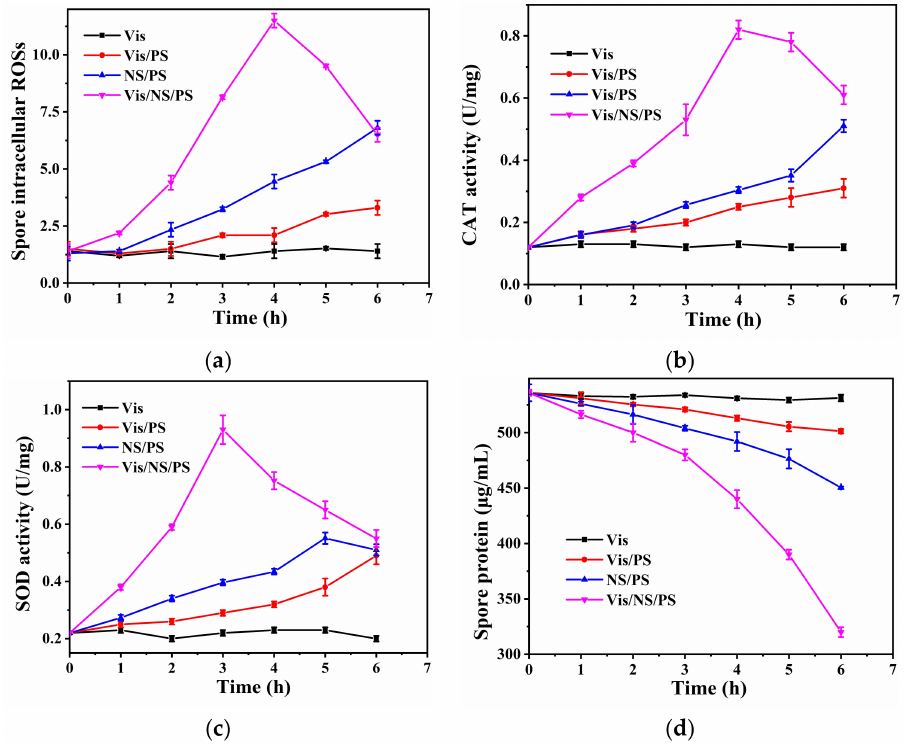
Figure 5. ( a ) Intracellular ROSs; ( b ) CAT activity; ( c ) SOD activity and ( d ) Protein concentration levels of bacteria spore in different treatment